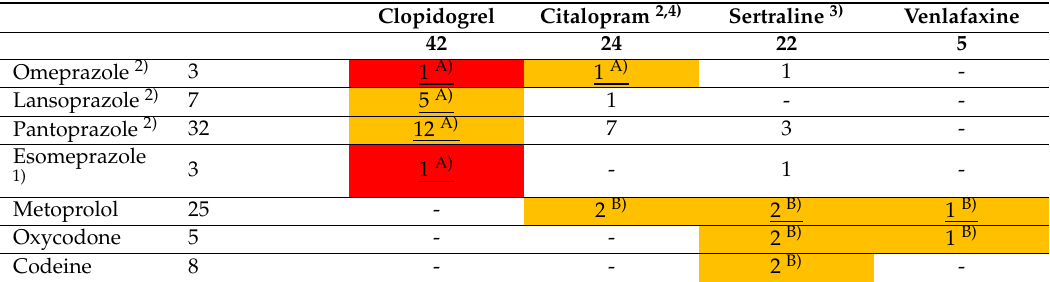
Table 4. Drug combinations with warnings related CYP2C19 and CYP2D6